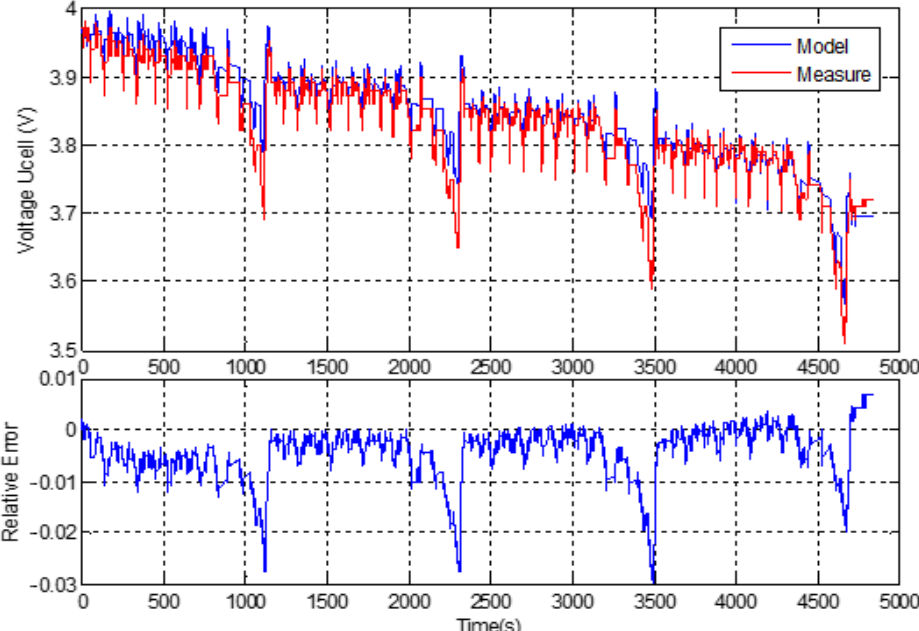
Figure 16. Verification test performed using 4 NEDC; comparison of the Rint model prediction with the experimental data and relative error is at the same level as in Figure 12.